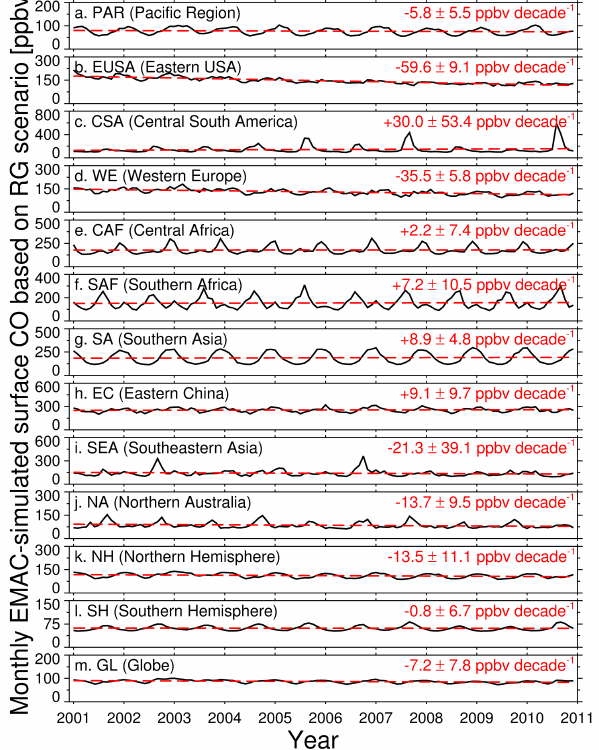
Figure 9. Regional and global trend estimates of monthly EMAC- simulated surface CO based on RG scenario with ± 2 σ errors from 2001 to 2010.